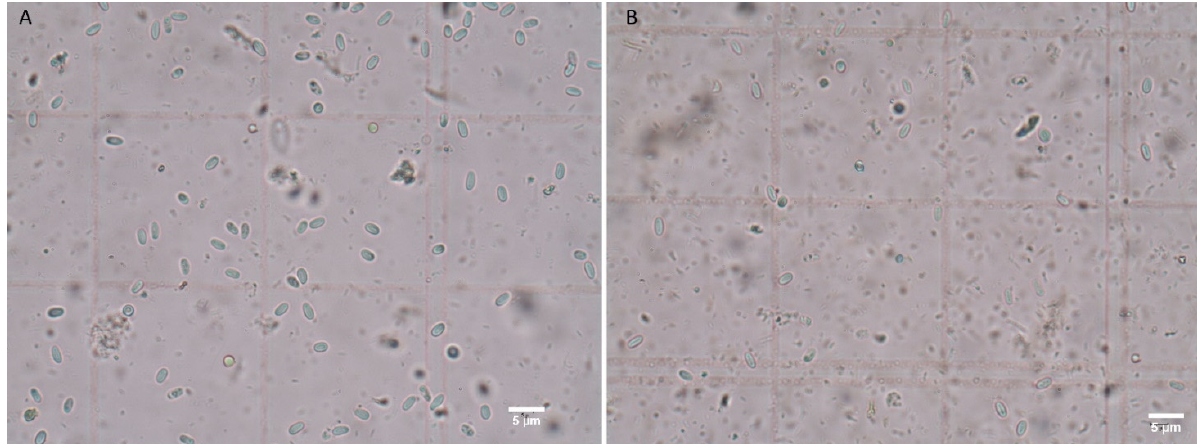
Figure 2. Microscopic images of Nosema spores in the intestine of Apis mellifera worker bees ( A ) and Galleria mellonella larvae ( B ). 12 days after mixed Nosema exposure. Figure scales are 5 µ